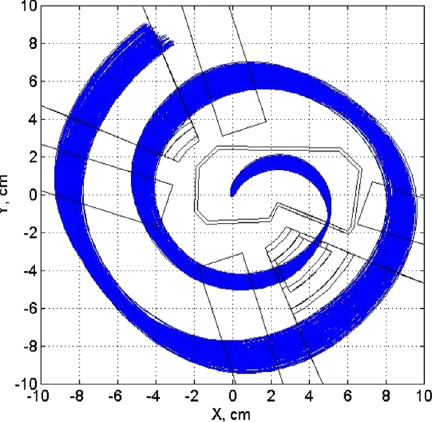
FIG. 9. Beam in the central region of cyclotron CYTRACK